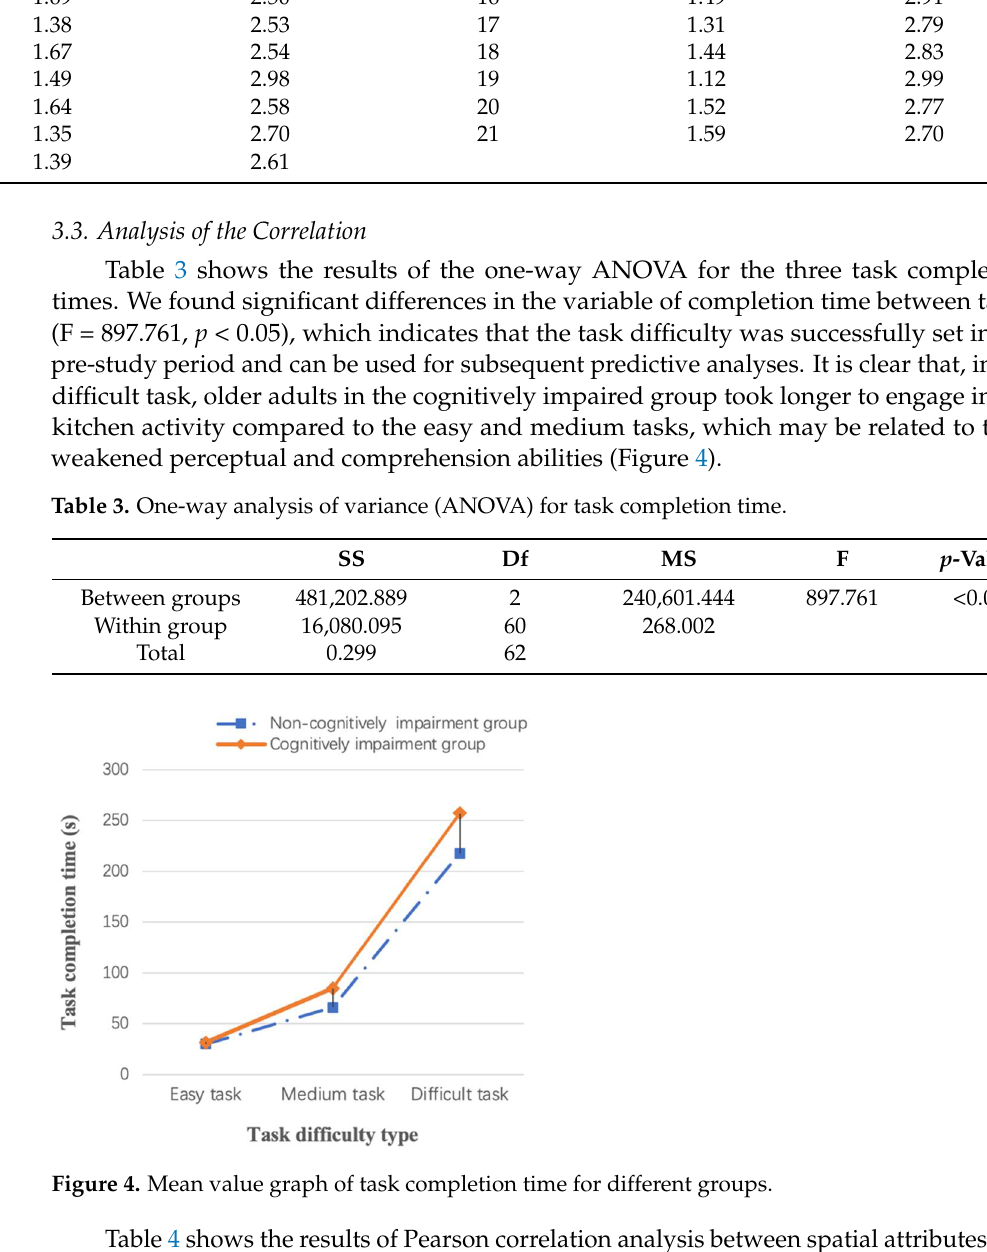
and integration or cognitive ability. Table 4. Analysis of correlation between the different task completion times and spatial proper- ties. Variables